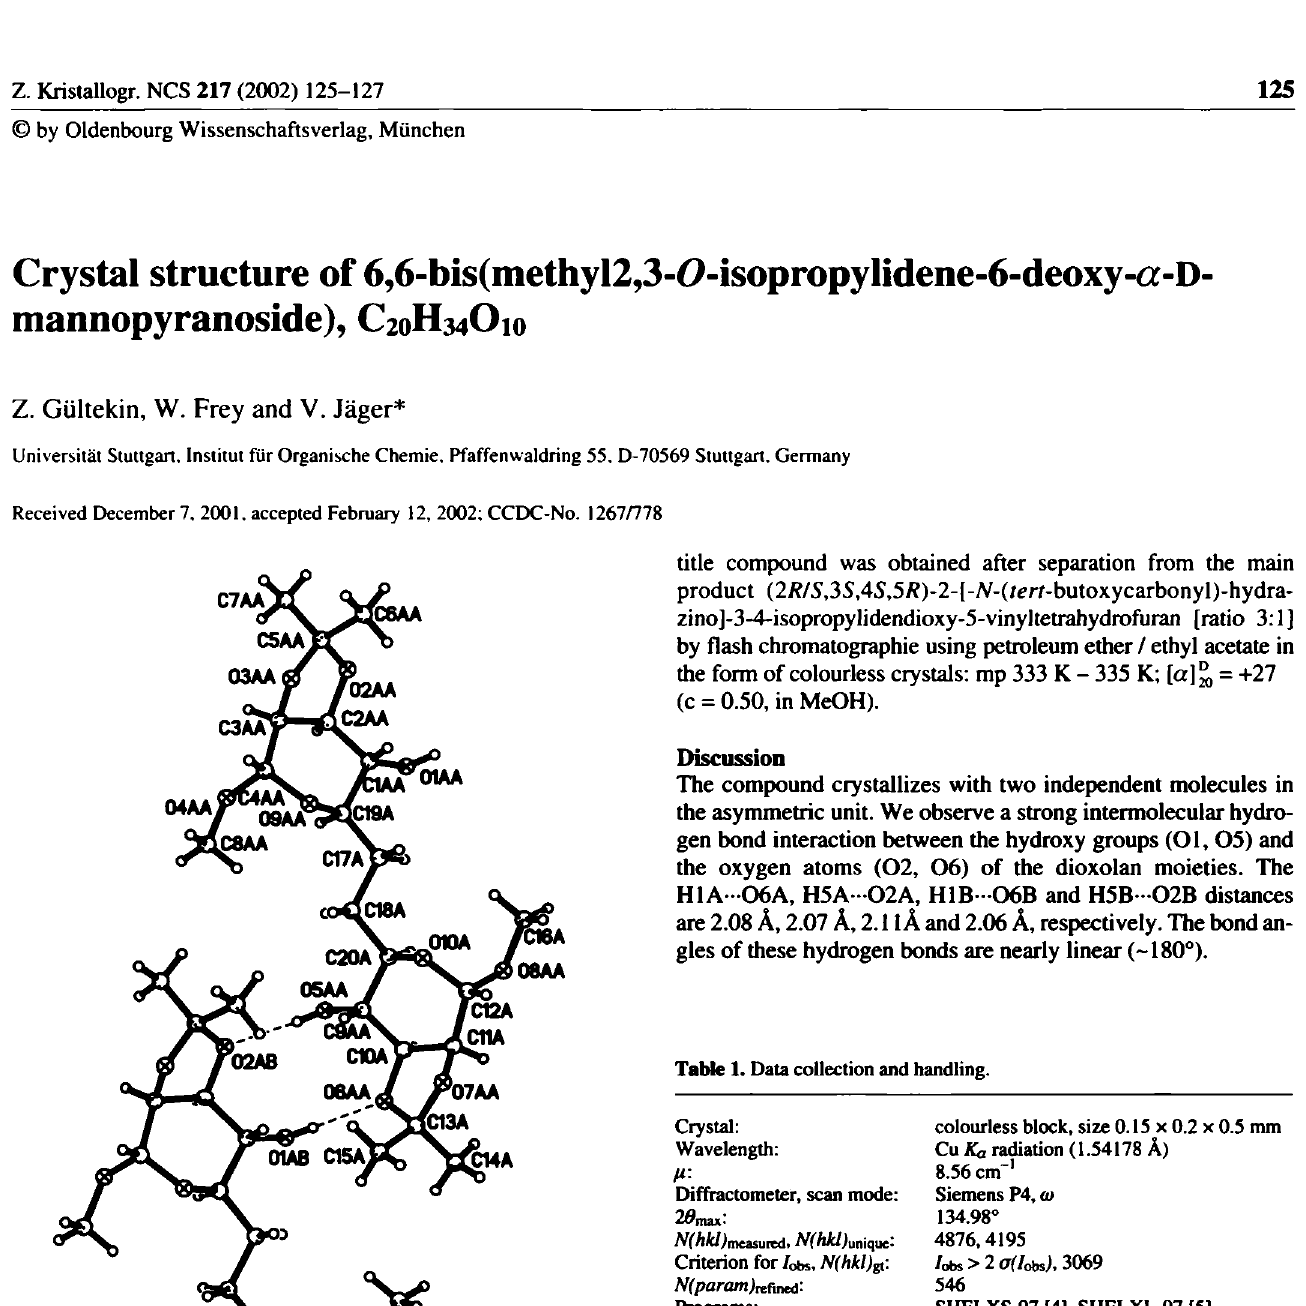
Table 2. Atomic coordinates and displacement parameters (in Â 2